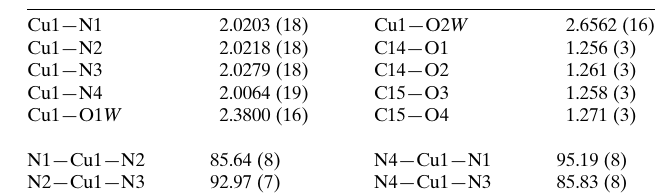
Table 1 Selected geometric parameters (A˚ , (cid:5) ).